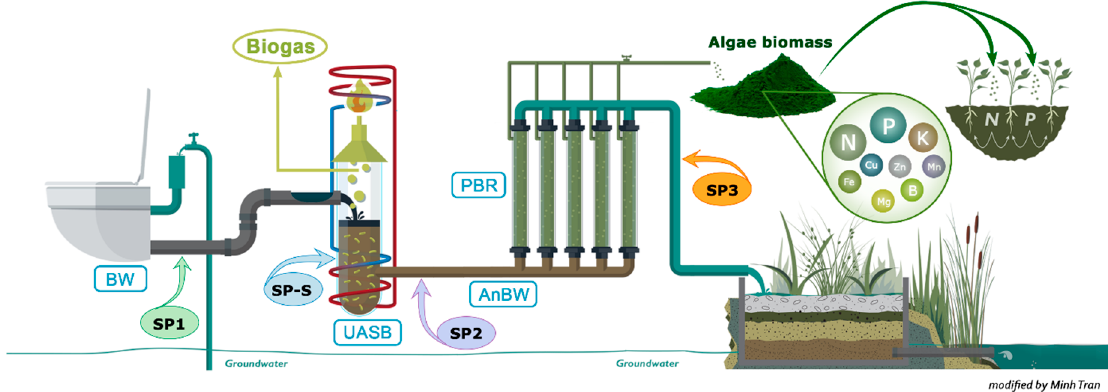
Figure 1. On-site black water treatment scheme at NIOO-KNAW used for the evaluation of the microbial communities in different treatment modules: blackwater (SP1), sludge from the UASB reactor (SP-S), anaerobic digested blackwater (SP2) and effluent from the tubular PBR (SP3).